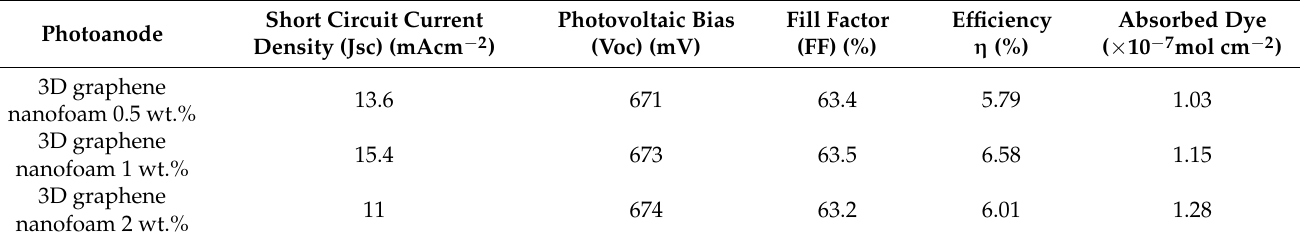
Table 3. Results of photovoltaic properties and dye loading of the DSSC with varied